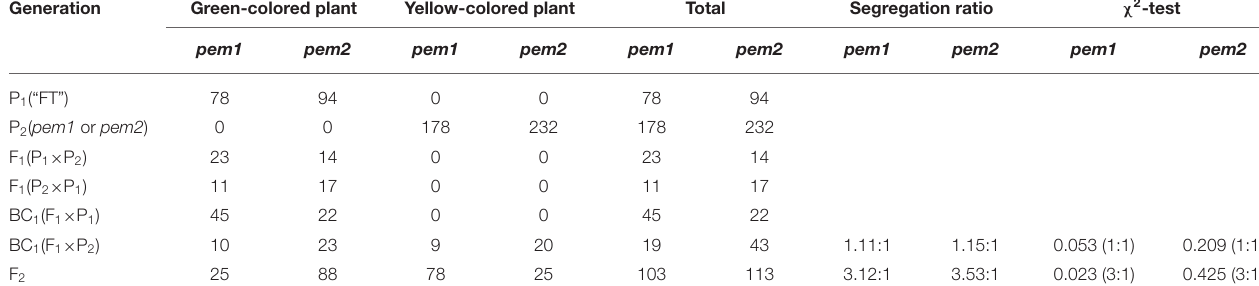
TABLE 2 | Genetic analysis of mutant pem1 and pem2 in Chinese cabbage. Generation Green-colored plant Yellow-colored plant